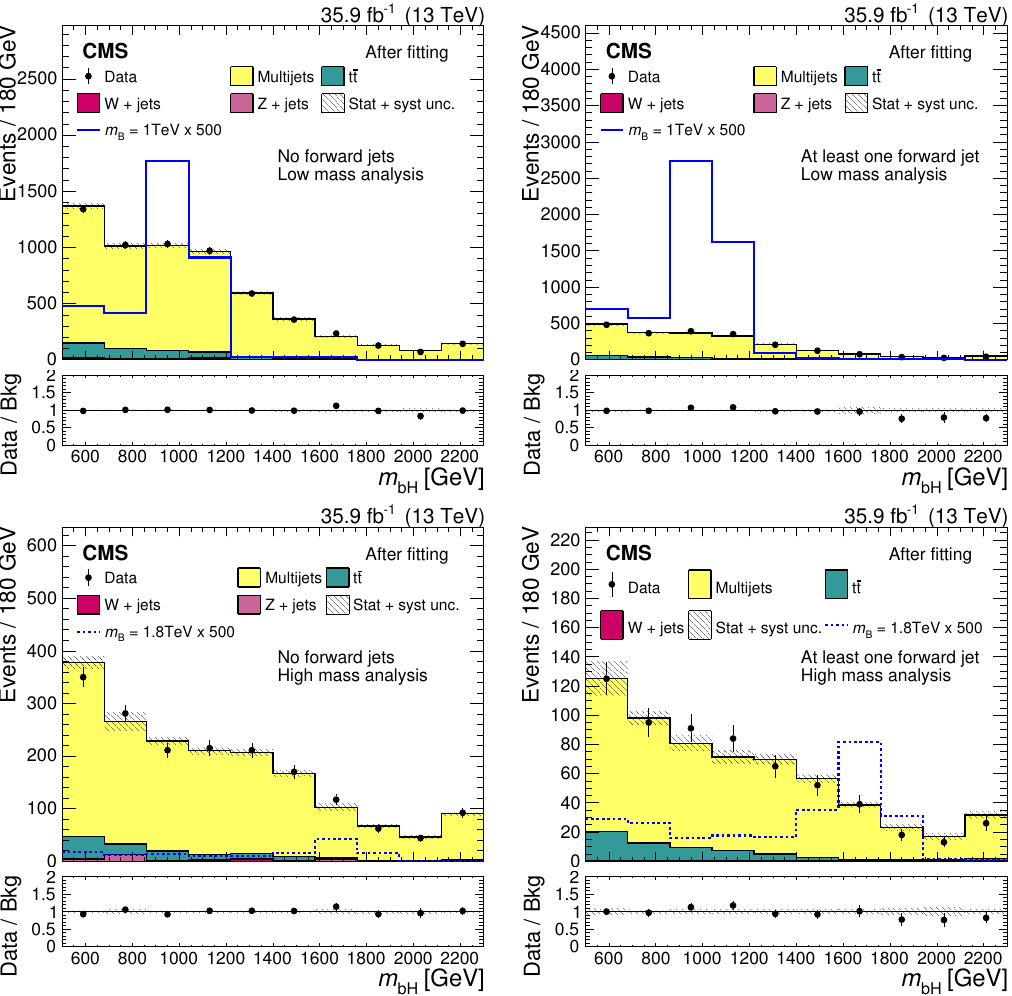
Figure 5. Distribution in the reconstructed B quark mass after applying all selections to events with no forward jets (left) and to events with at least one forward jet (right), compared to the background distributions estimated after (cid:12)tting. The upper and lower plots refer to the low- and high- m B analyses, respectively. The expectations for signal MC events are given by the blue lines. The di(cid:11)erent background contributions are indicated by the colour-(cid:12)lled histograms, and are obtained from Monte Carlo simulation, except for the multijets component, which is derived from data. The grey-hatched error band shows total uncertainties in the background expectation. The ratios of the observations to background expectations are given in the lower panels, together with the total uncertainties after (cid:12)tting, indicated by the grey-hatched